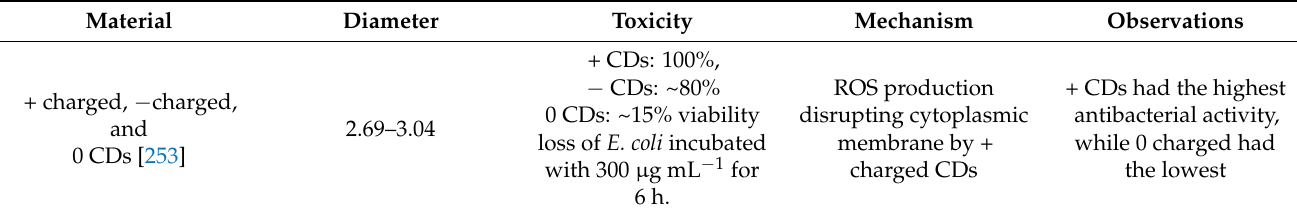
Figure 12. ( a , b ) Confocal laser scanning microscopy (CLSM) images of S. aureus (Gram-positive) treated with CDs (25 μ g mL − 1 ) for 1 h at 4 and 37 ° C . ( c , d ) The CLSM images of E. coli (Gram-negative) treated with CDs (25 μ g mL − 1 ) for 1 h at 4 and 37 ° C . ( λ ex = 405 nm; emission was collected at 415 − 550 nm, for both strains). ( e , f ) SEM images of S. aureus and E. coli after incubation without and with CDs at 60 μ g mL − 1 for 12 h, respectively. ( g ) CLSM images of Rhizoctonia solani treated with CDs and Red Dot 1 for 30 min at 37 ° C : (I) bright field, (II) CDs (200 μ g mL − 1 ; λ ex = 405 nm; emission was collected at 415 − 550 nm), (III) Red Dot 1 (200× in water; λ ex = 543 nm; emission was collected at 580 − 750 nm), and (IV) merge of images (the blue traces marked 1 and 2 are nucleus and ruptured nucleus, respectively). Reprinted with permission from ACS Applied Materials and Interfaces , by Hao Li, Jian Huang, Yuxiang Song, et al., Degradable Carbon Dots with Broad-Spectrum Antibacterial Activity , 10, 26936 [262]. Copyright 2018 American Chemical Society. Table 5. CDs as antibacterial agents.